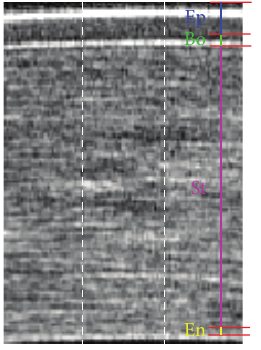
Figure 4: The four sublayers to be estimated with the ROI subdivi- sion into three adjacent slides.